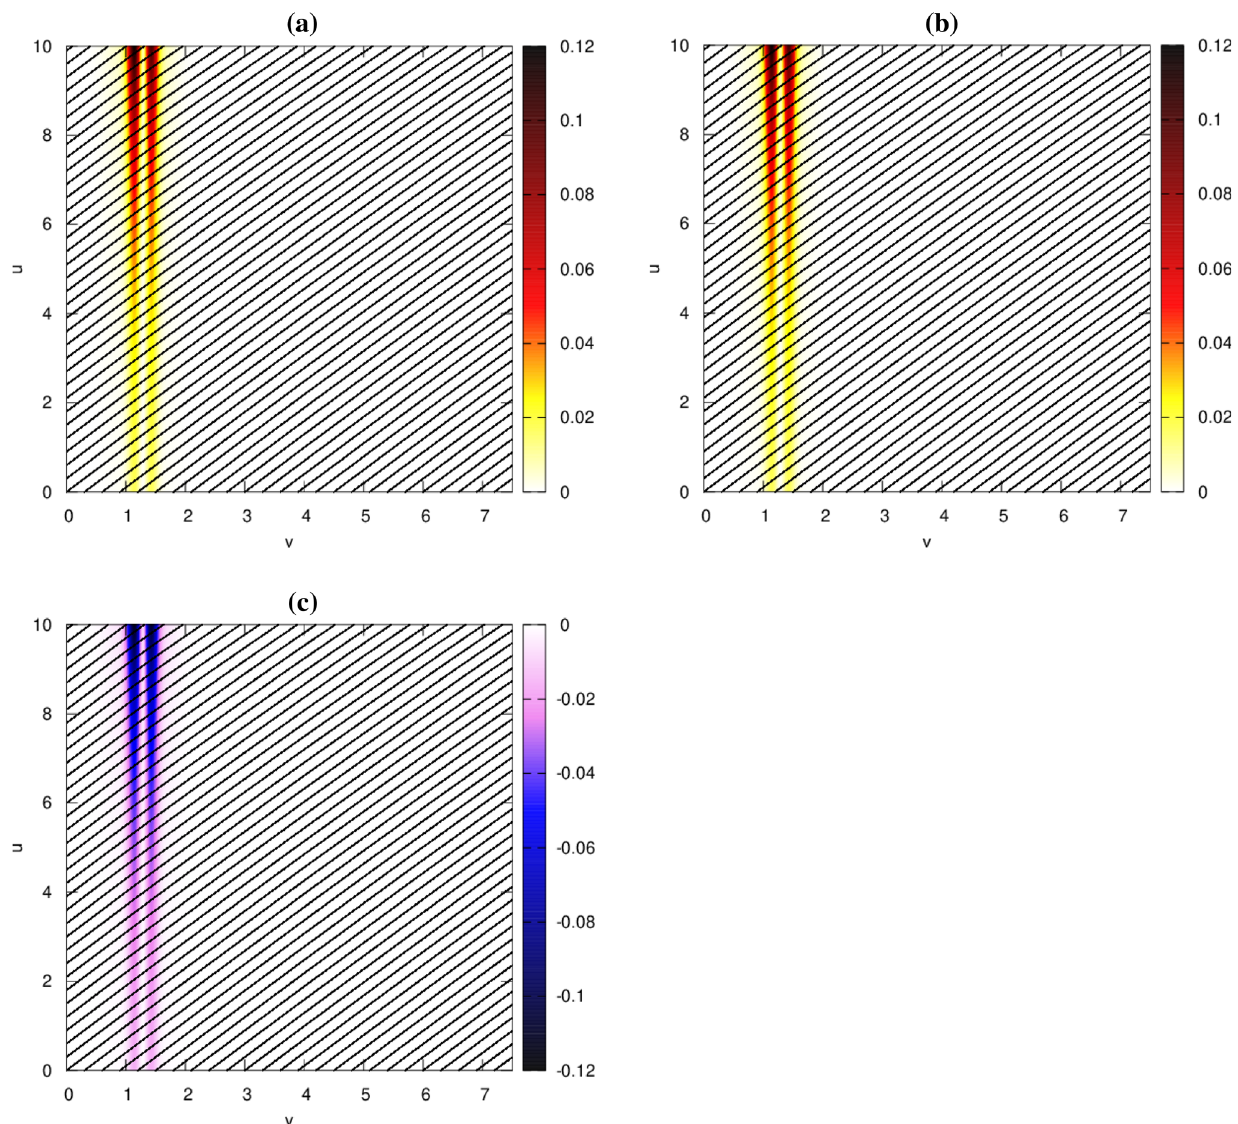
Fig. 5 The (v u ) -distribution of a energy density, ˆ ρ , b radial pressure, ˆ p r , and c pressure anisotropy, ˆ p a , for a dynamical evolution characterized by parameters λ X = λ hX = 0 . 1, m 2 = 0 . 25, ξ X = ξ h = 0, α m = 0 . 1 and the field amplitudes ˜ p X = ˜ p h = 0 .